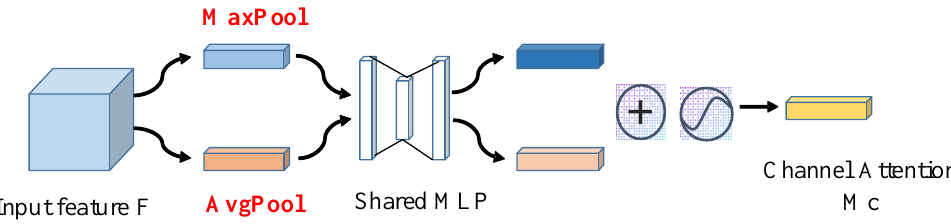
Figure 3. Channel attention